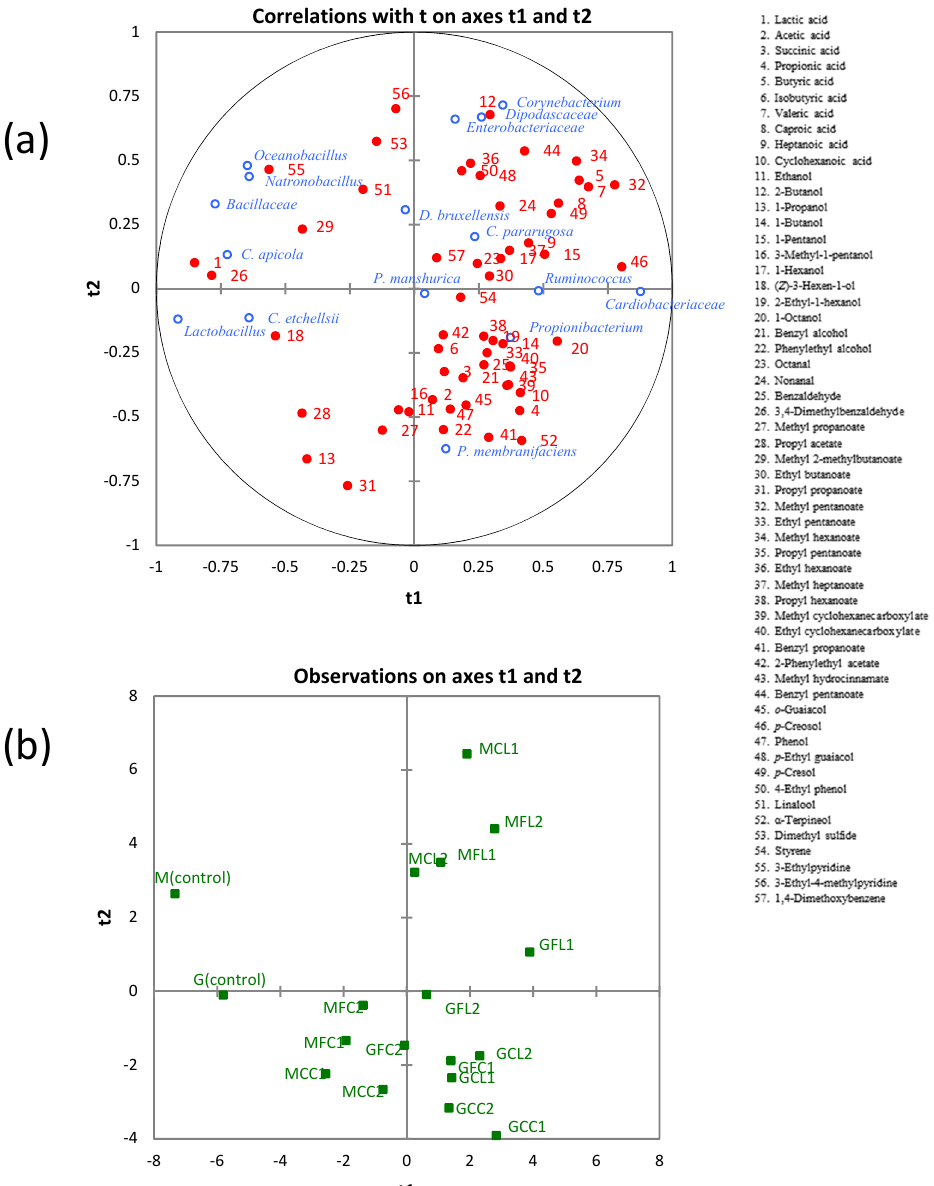
Figure 7. The PLS regression between microbial communities and metabolites. ( a ) Loading plot. ( b ) Score plot. See Table 5 for the meanings of samples abbreviations.